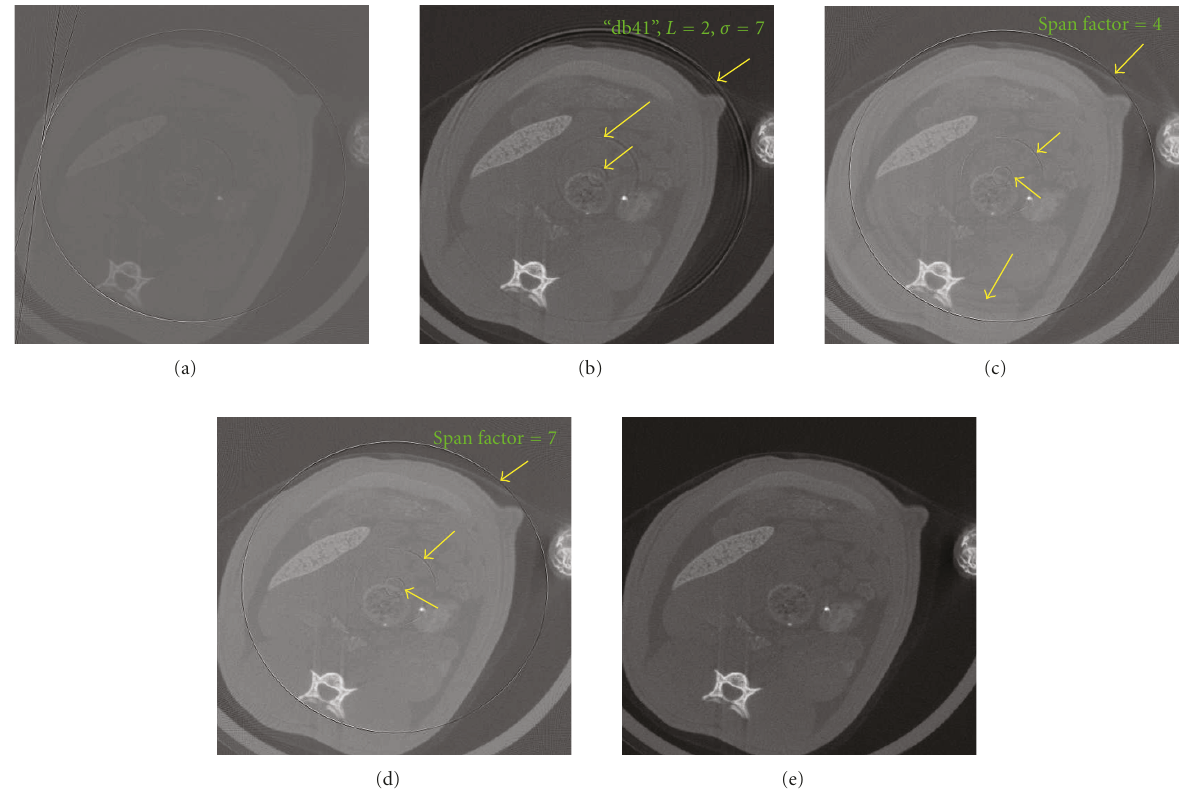
Figure 9: Reconstructed images of Rat Abdomen-3 from the corrected sinogram using di ff erent methods. (a): Original image, (b): Wavelet- Fourier method, (c): MA method, (d): Median method, and (e): Proposed method.